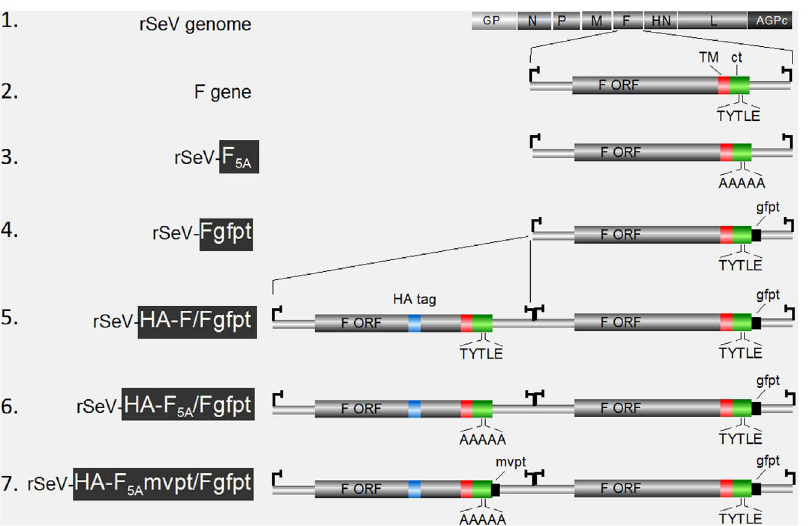
Figure 1. Schematic representation of the recombinant SeV genomes. 1 . Genes encoding N, P, M, F, HN and L are flanked by genomic promoter (GP) and complement of anti-genomic promoter (AGPc). 2 . Blow up of the F transcription unit as present in wt SeV genome, flanked by the start/stop transcription